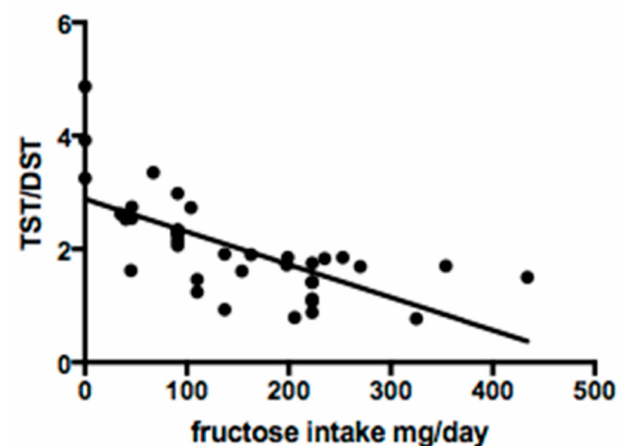
Figure 3. Linear regression between fructose intake and tetrasialotransferrin / disialotransferrin ratio (TST /